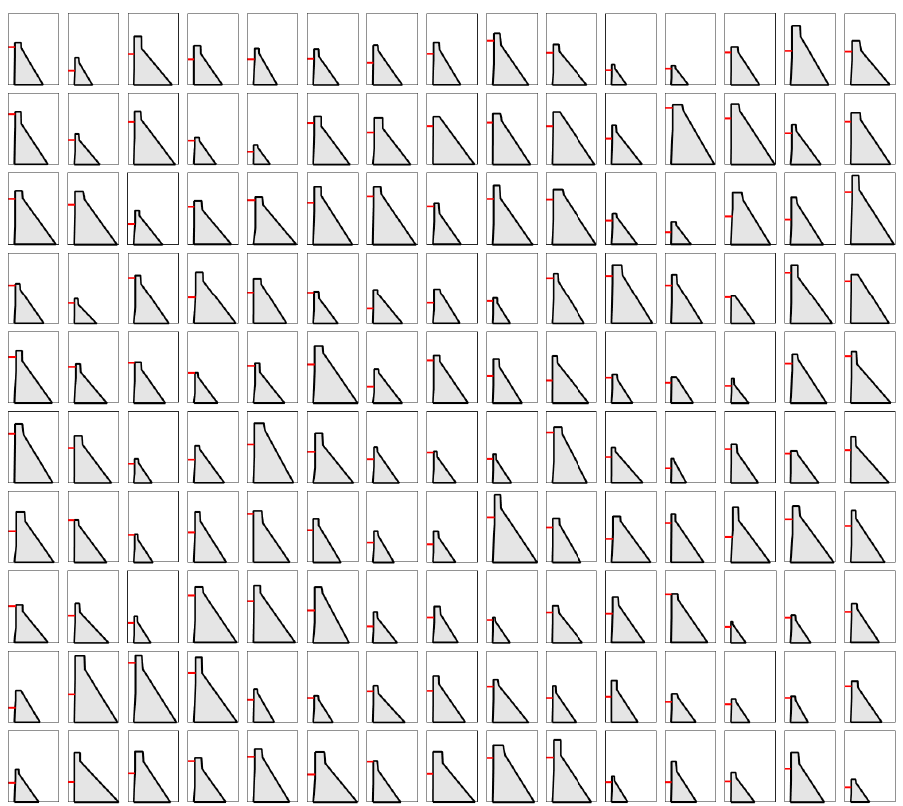
Figure 3. Inventory of all gravity dam shapes generated based on a Matlab code including a random water level in red; the box size is 170 240 m in all cases. ×